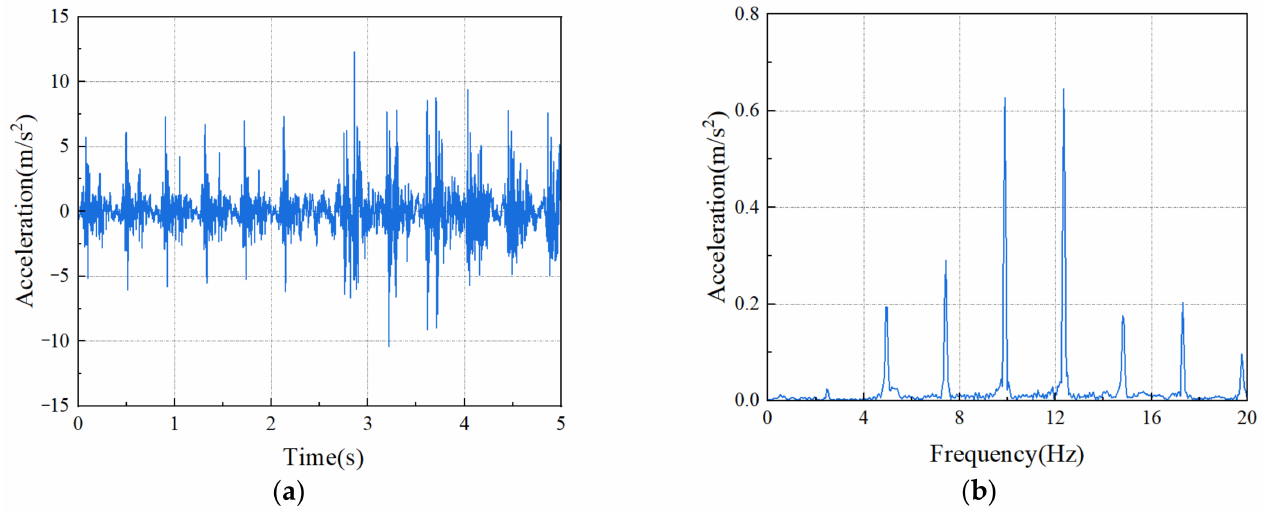
Figure 10. Vibration acceleration excitation for crushing condition: ( a ) Time domain; ( b ) Frequency